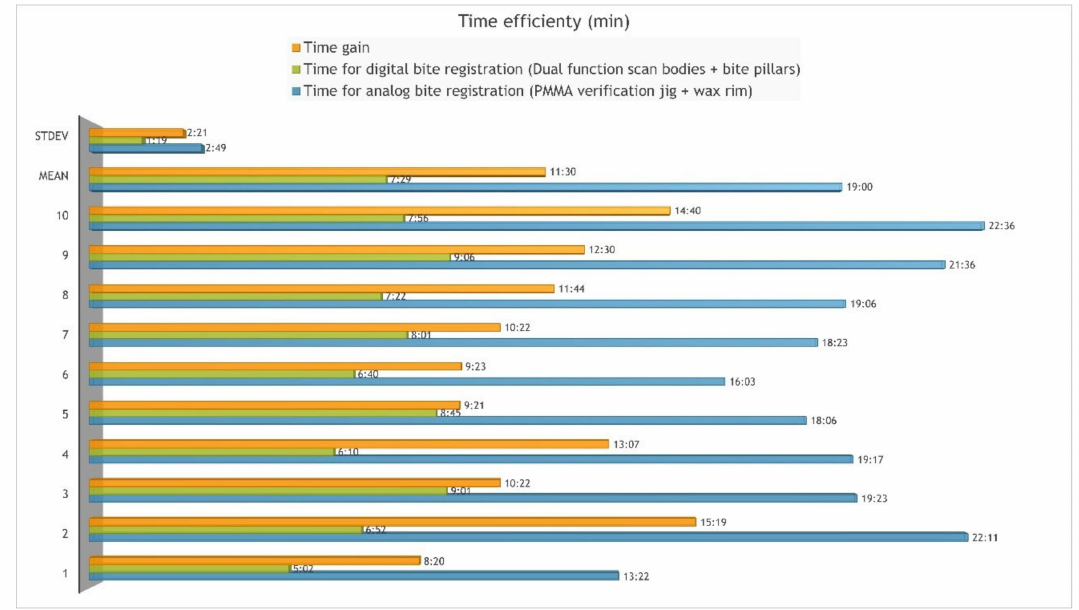
Figure 13. Time efficiency of digital vs. analog bite registration technique. Bilateral balanced CO positions were registered in all patients during digital bite registration on at least one bite pillar per quadrant. The mean percentage of scan bodies establishing a stable contact with the antagonistic dentition was 69% (range 50–100%) per patient.